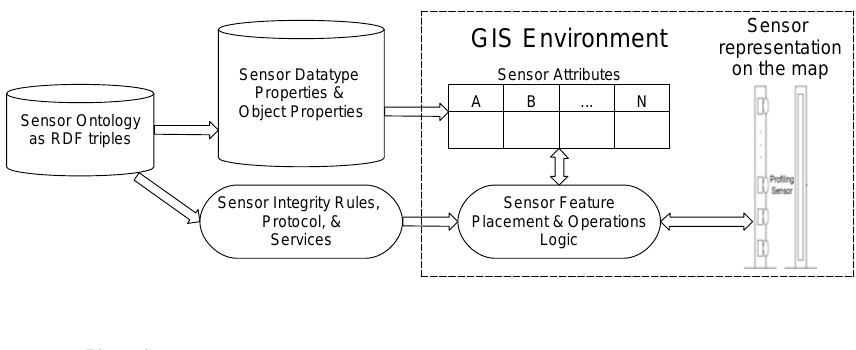
Figure 7. Interaction between sensor ontology and GIS environment